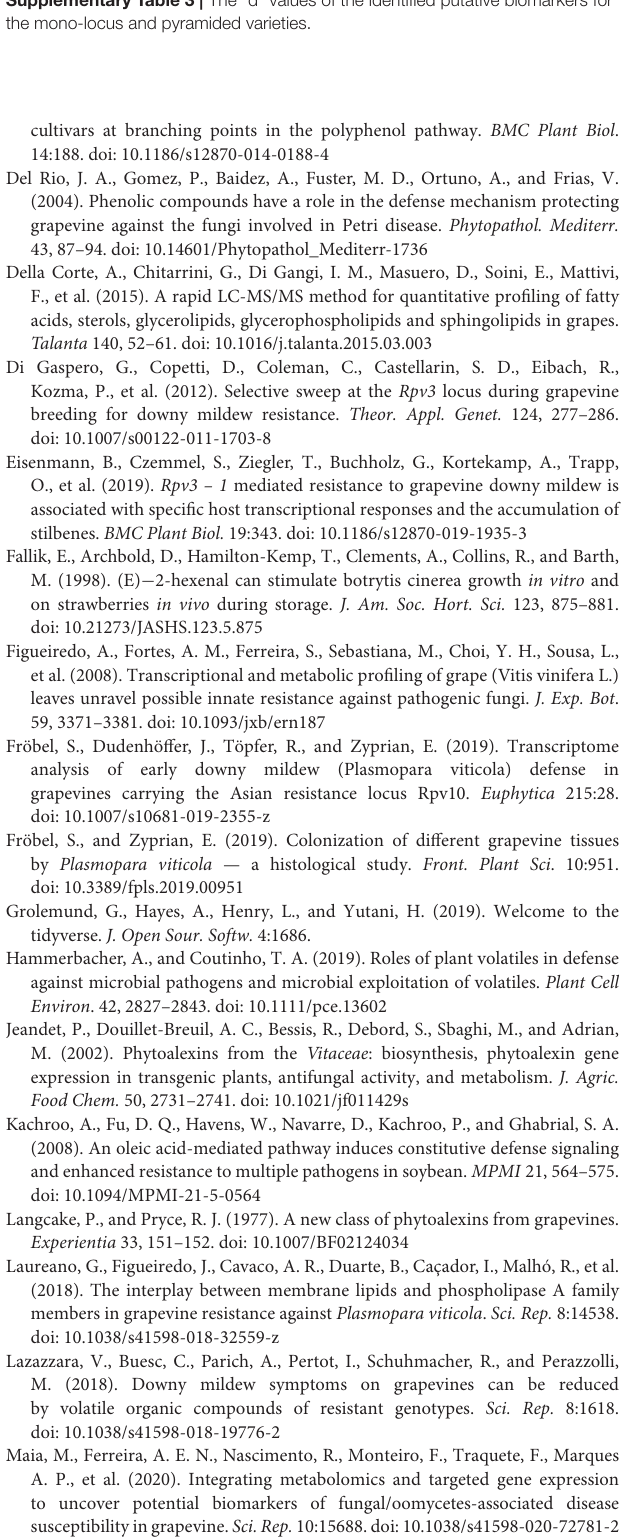
Supplementary Table 2 | Concentrations of the 22 compounds identified as putative markers of resistance (see section The Effect of Pathogen Inoculation) (VOCs in sheet 1; Lipids in sheet 2 and Polyphenols in sheet 3) and the four stilbenes and stilbenoids involved in the response to the infection (see section